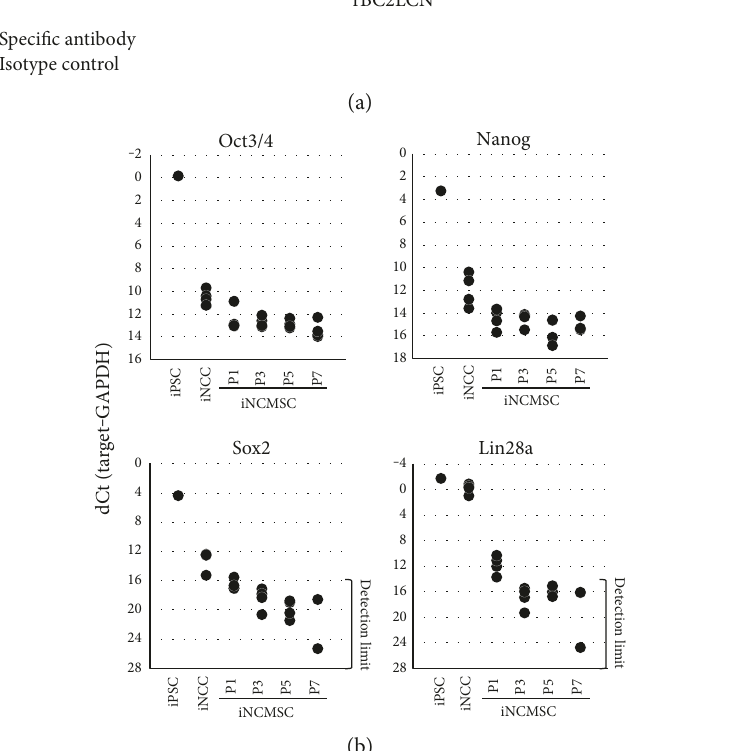
Figure 2: Depletion of pluripotent markers in iNCMSCs. (a, b) FACS analysis of PSC-speci fi c surface antigen and gene expression analysis of PSC-speci fi c transcript factors in iPSCs, iNCCs, and iNCMSCs. 409B2-iPSCs were used for positive control of each assays. Abbreviations: PSCs: pluripotent stem cells; iNCCs: induced neural crest cells; iPSCs: induced pluripotent stem cells; iNCMSCs: iNCC-derived mesenchymal stem